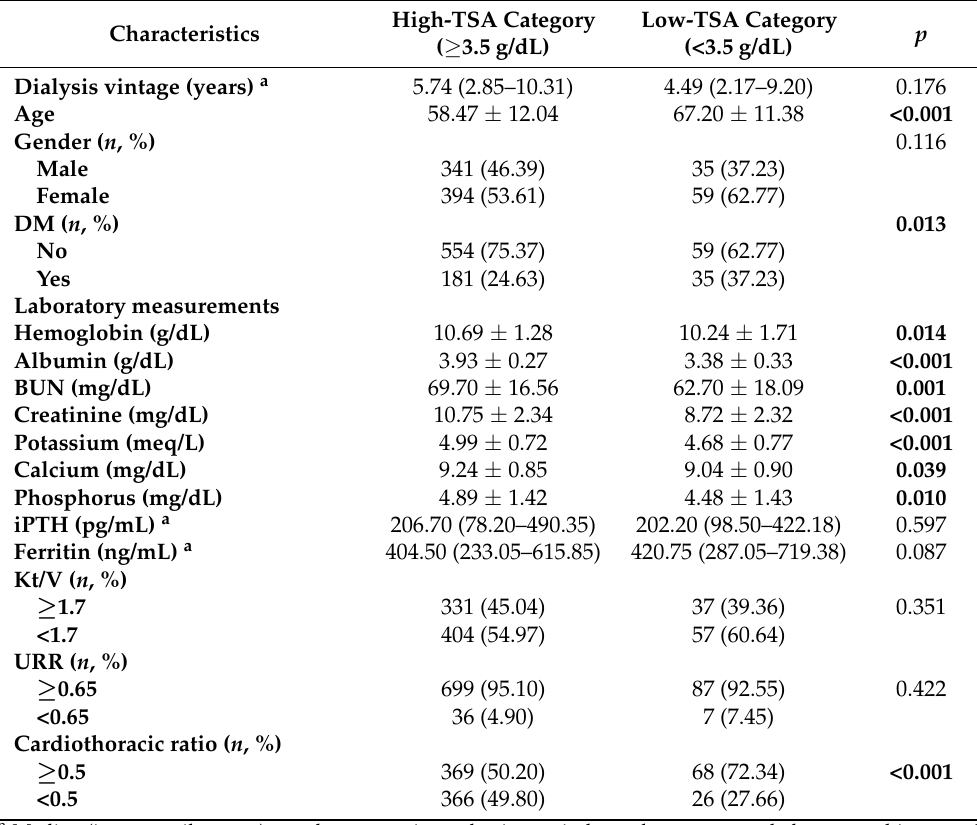
Table 1. Baseline characteristics of hemodialysis patients in different time-averaged serum albumin (TSA) categories ( n =